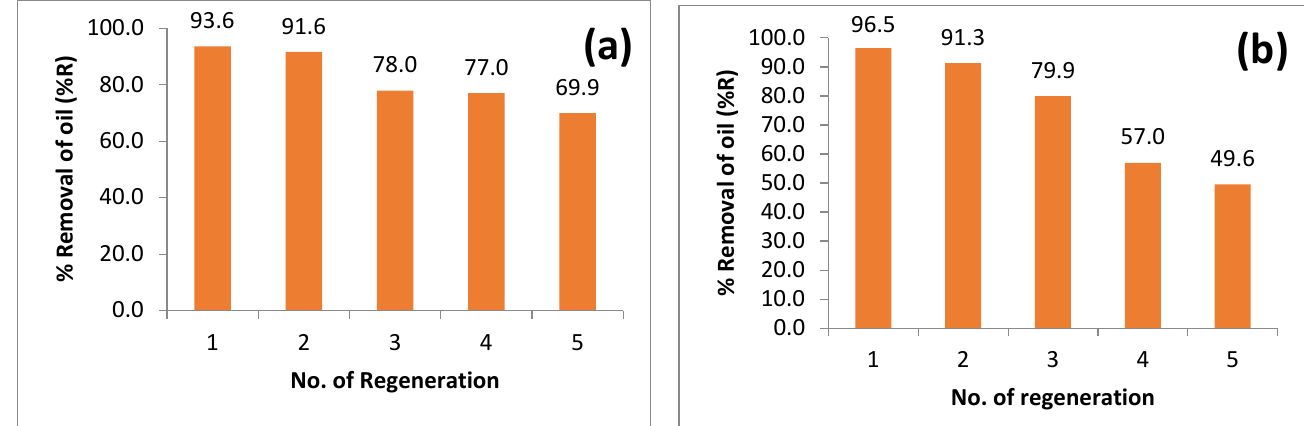
Figure 21. Regeneration of ( a ) AR adsorbent and ( b ) AB adsorbent.